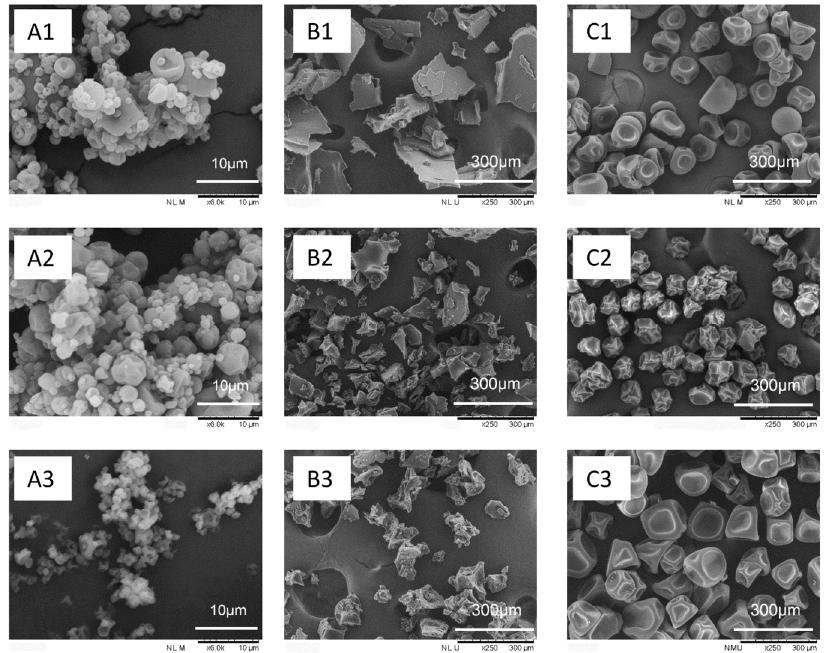
Figure 2. Microstructure of microcapsules. ( A1 ) SD-W, ( A2 ) SD-O, ( A3 ) SD-WO at 6000 × magnification; ( B1 ) FD-W, ( B2 ) FD-O, ( B3 ) FD-WO at 250 × magnification; ( C1 ) MFJSD-W, ( C2 ) MFJSD-O, ( C3 ) MFJSD-WO at 250 × magnification. SD-W, SD-O, and SD-WO: microcapsules produced by two-fluid nozzle spray drying, using WPI only, OSA only, and a combination of WPI/OSA (50/50 w/w ) as wall materials, respectively; FD-W, FD-O, and FD-WO: microcapsules produced by freeze-drying, using WPI only, OSA only, and a combination of WPI/OSA (50/50 w/w ), as wall materials, respectively; MFJSD-W, MFJSD-O, and MFJSD-WO: microcapsules produced by microfluidic-jet spray drying, using WPI only, OSA only, and a combination of WPI/OSA (50/50 w/w ) as wall materials, respectively. WPI: whey protein isolate; OSA: octenylsuccinic anhydride modified starch.